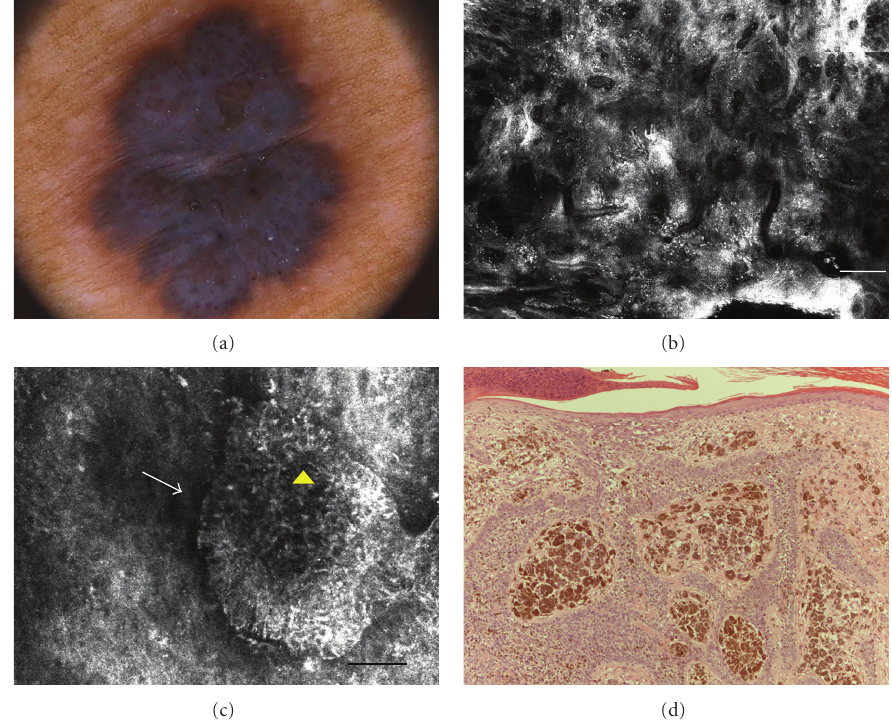
Figure 2: (a) Dermoscopic image of pigmented nodule exhibiting a bluish veil on the entire lesion and numerous vessels with corkscrew aspect (original magnification 20 × ). (b) RCM image (4 × 4mm) imaged at upper dermis level, showing the cauliflower aspect with numerous plump bright cells overlying all lesion area (scale bar: 500 µ m). (c) RCM image (0 . 5 × 0 . 5 mm) showing reflective aggregates of tightly packed cells with peripheral palisading ( white arrow ) surrounded by dark clefts. Inside the tumoral nest bright filaments and dots were present ( yellow arrowhead ) (scale bar: 50 µ m). (d) Histology showing basaloid tumoral nests enclosed by connective tissue stroma. Melanin was present inside the tumoral nests and also in the surrounding stroma where numerous melanophages were detected (H&E section; original magnification ×